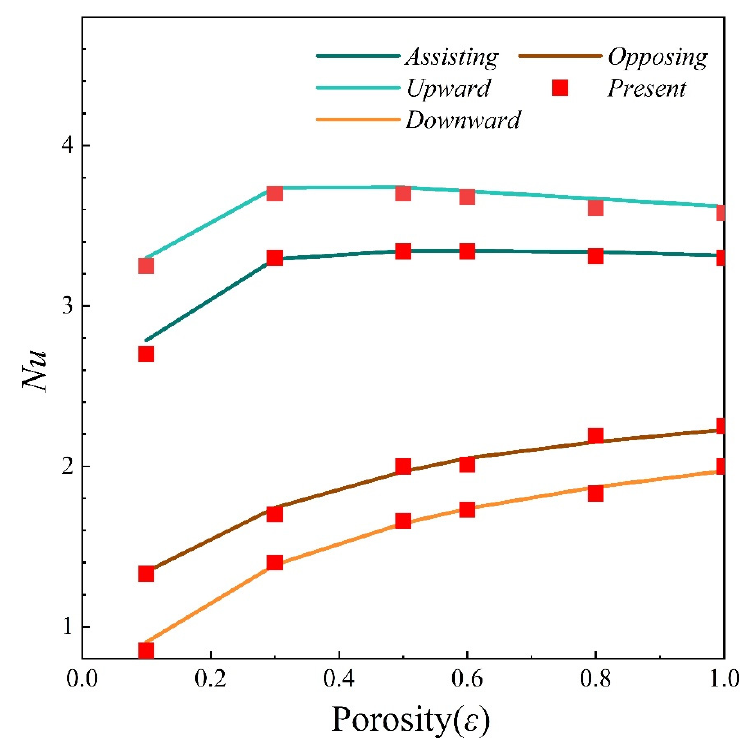
Figure 3. Mixed convention at Re = 400 from Siegmann ‐ Hegerfeld et al. [68] and the present work. ( a ) Present work; and ( b ) Photograph (left), computed streamlines (middle), and PIV vector maps (right) from Siegmann ‐ Hegerfeld et al .